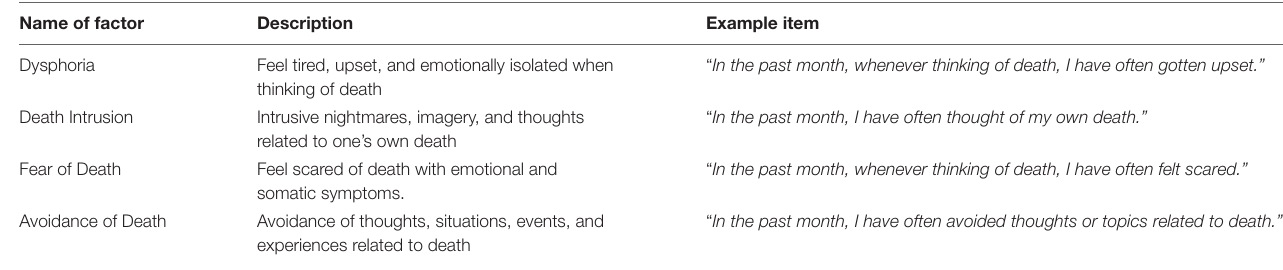
TABLE 2 | Description of factors identified in Study